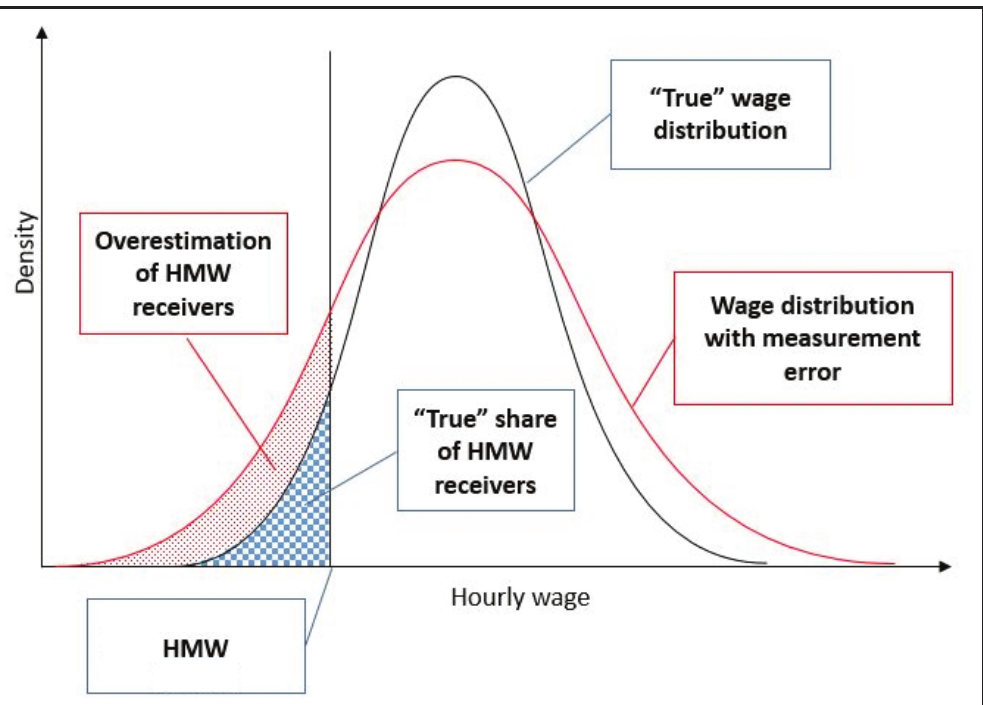
Figure B1 Distribution of gross hourly